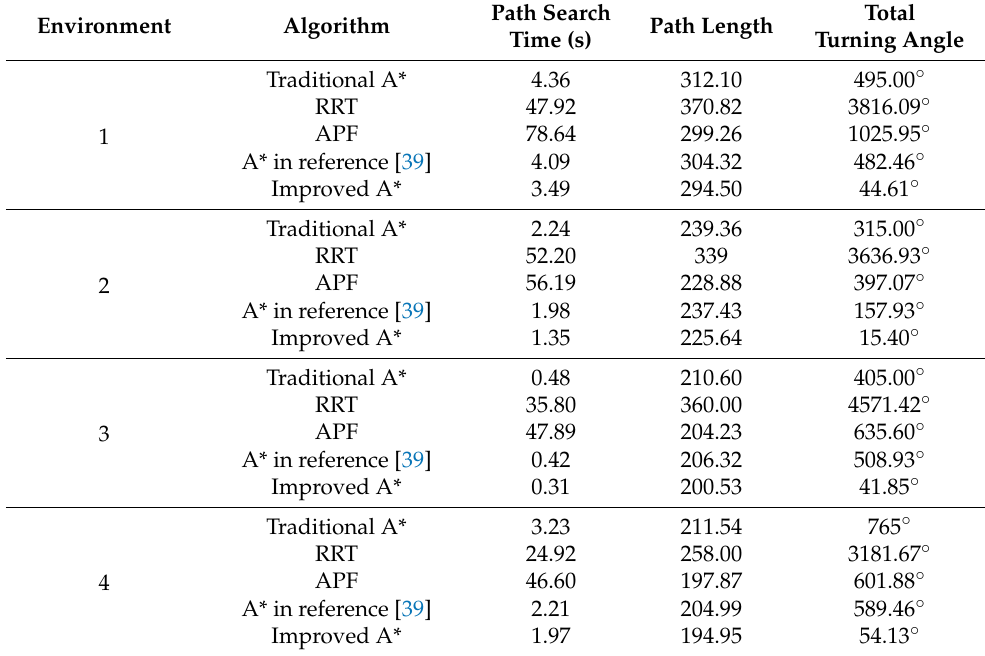
Table 3. Algorithm performance for different starting points and target point